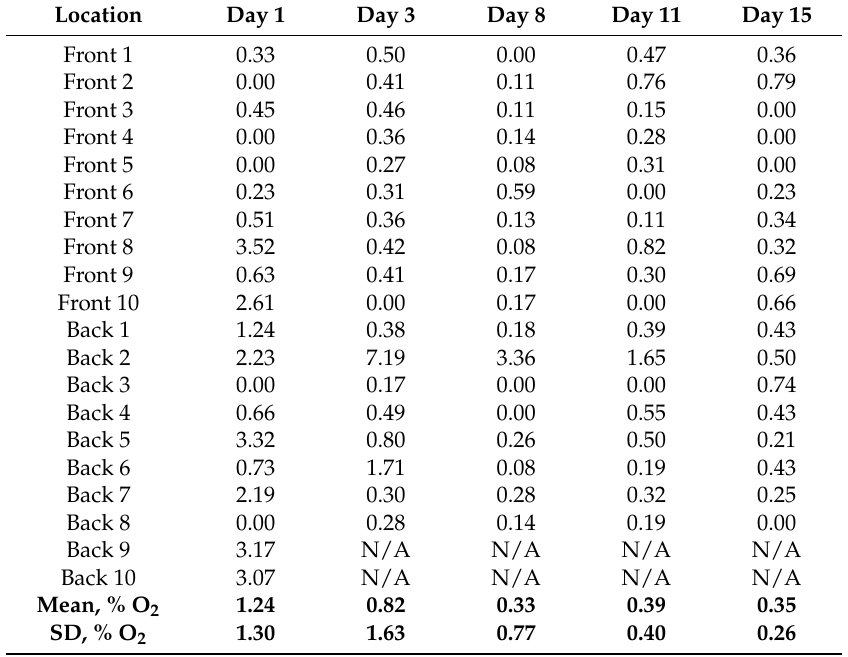
Table 2. Residual O 2 level readings (%) for each sensor contained in Bin 2 over a 15-day storage period.